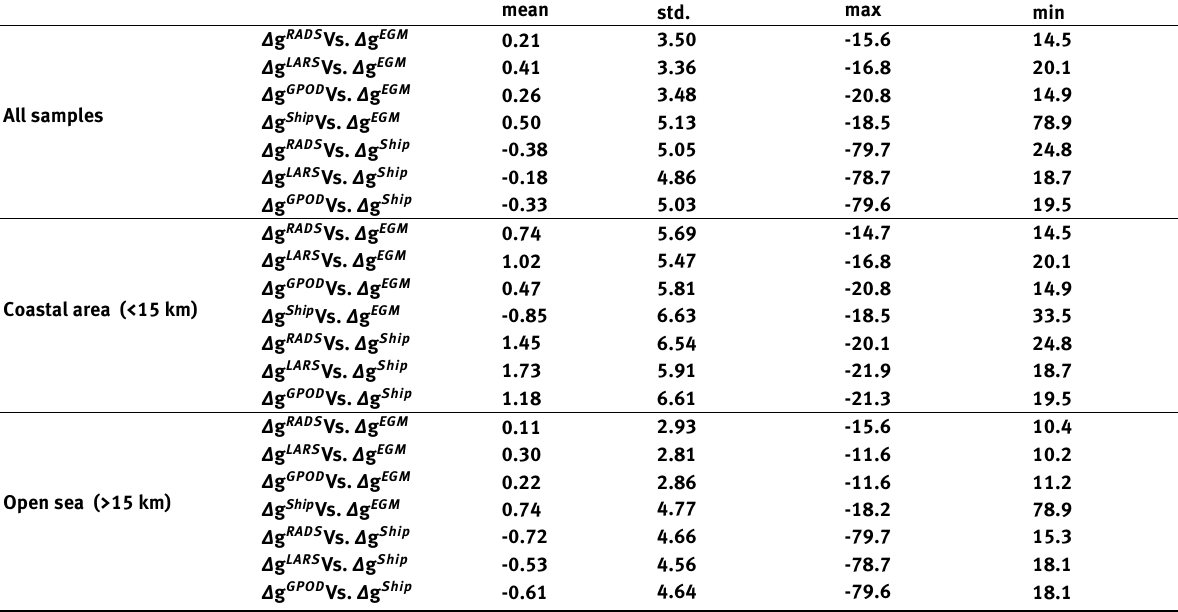
Table 2. Statistic of the difference between predicted gravity anomalies from 3 different datasets, shipborne gravimetry ∆ gShip and EGM2008, in total 2264 samples. Based on the distance away from the nearest coastal line (15 km), 347 samples are located in the "Coastal area". The other 1917 points are used as "Open sea" samples. Unit: